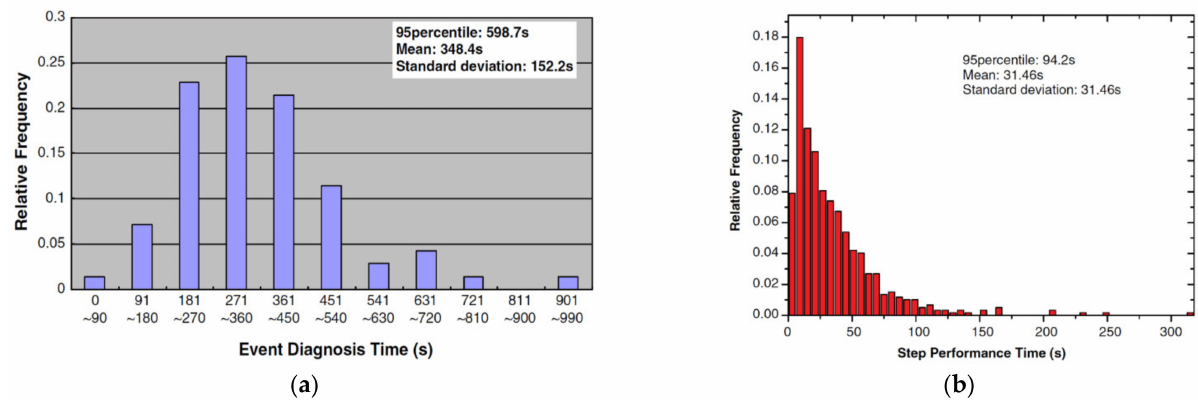
Figure 3. Human action timeline distribution for: ( a ) the event diagnosis time; ( b ) the step performance time (Reproduced from [29], Elsevier: